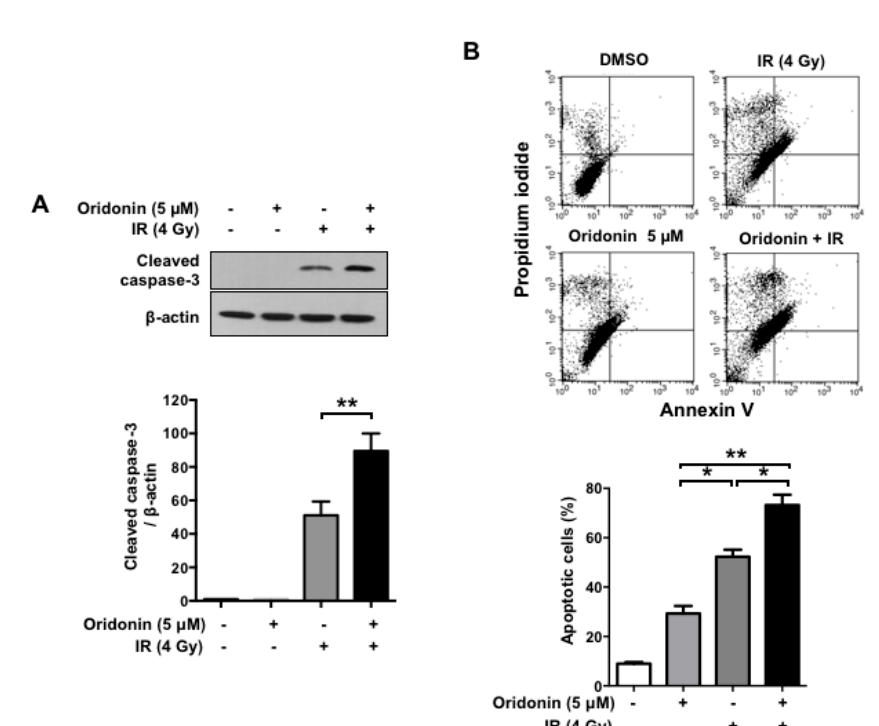
Figure 5. Effect of oridonin on radiation-induced cleavage of caspase-3 and cell death. Cells were treated with oridonin (5 µM) and/or IR for 72 h. ( A ) Representative Western blots ( upper panel ) and plotted, quantified data ( lower panel ) for cleaved caspase-3; ( B ) cells were stained with Annexin V-FITC/PI prior to flow cytometry analysis. Apoptotic cells were estimated by the sum of the upper left , upper right , and lower right quadrants in each dot plot. Plotted values represent the percentages of apoptotic cells. All plotted data represent the means ± SEM of three independent experiments * p < 0.05 and ** p < 0.01. FITC, fluorescein isothiocyanate; PI, propidium iodide.